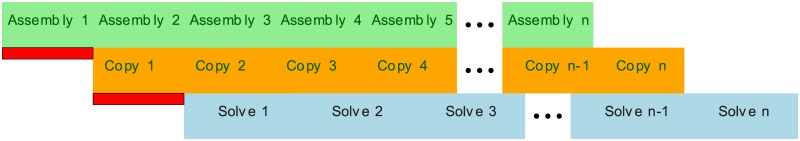
This figure shows a communication hiding pattern that interleaves the assembly (green; on the Xeon Phi), the copy (orange; data transfer from the Xeon Phi to the CPU), and the linear solve (blue; on the CPU).The red areas constitute the remaining overhead that decreases as we divide our problem into smaller and smaller slices.